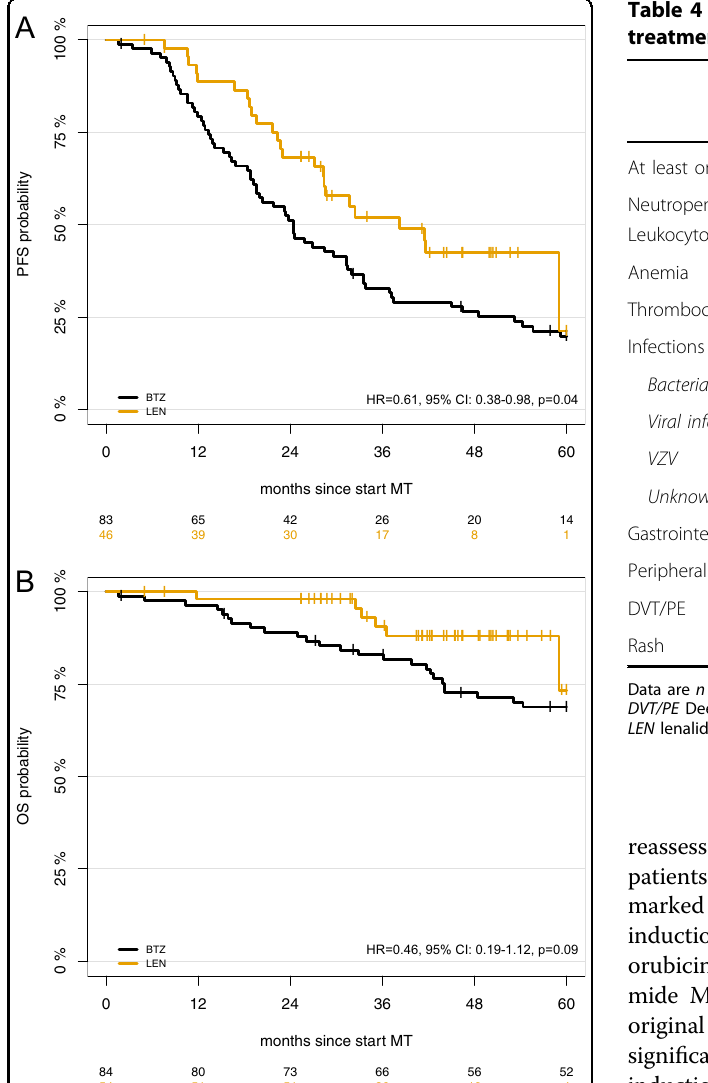
Table 4 Grade ≥ 3 adverse events during